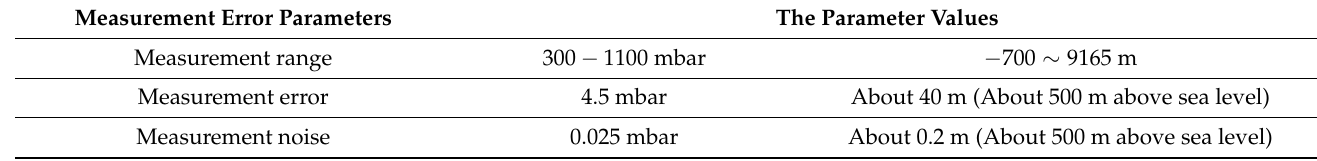
Table 1. The performance parameters of the barometer we use. The errors of the barometer mainly consist of the measurement error and measurement noise. The absolute error of measurement reaches 40 m. Measurement Error